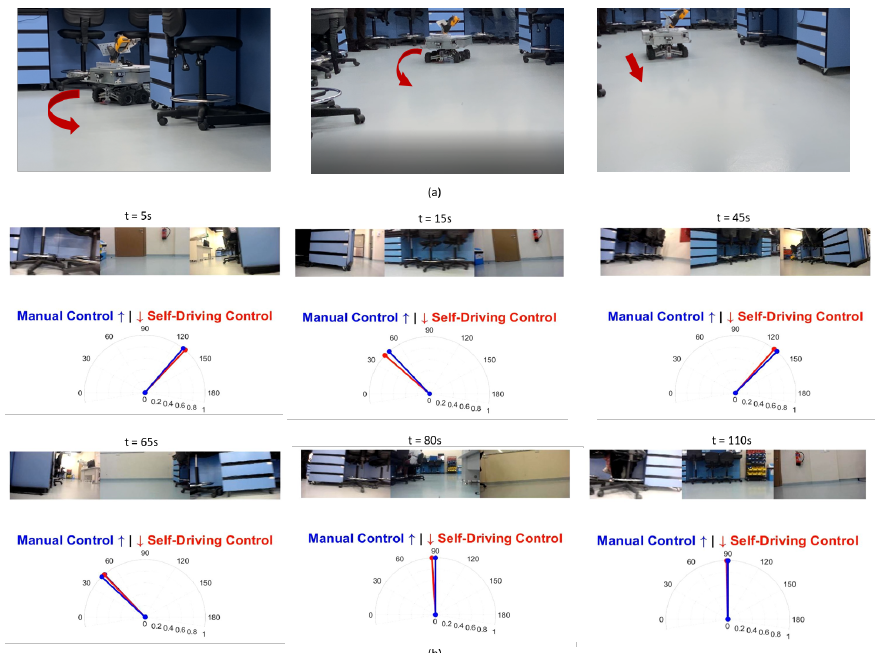
Figure 13. [Lab test run 1] Self-Driving in the lab environment results: Figures in ( a ) show the robot turning around the center bench autonomously then moving forward after turning. Figures in ( b ) represent the robot’s view and the true vs. regressed steering angles.